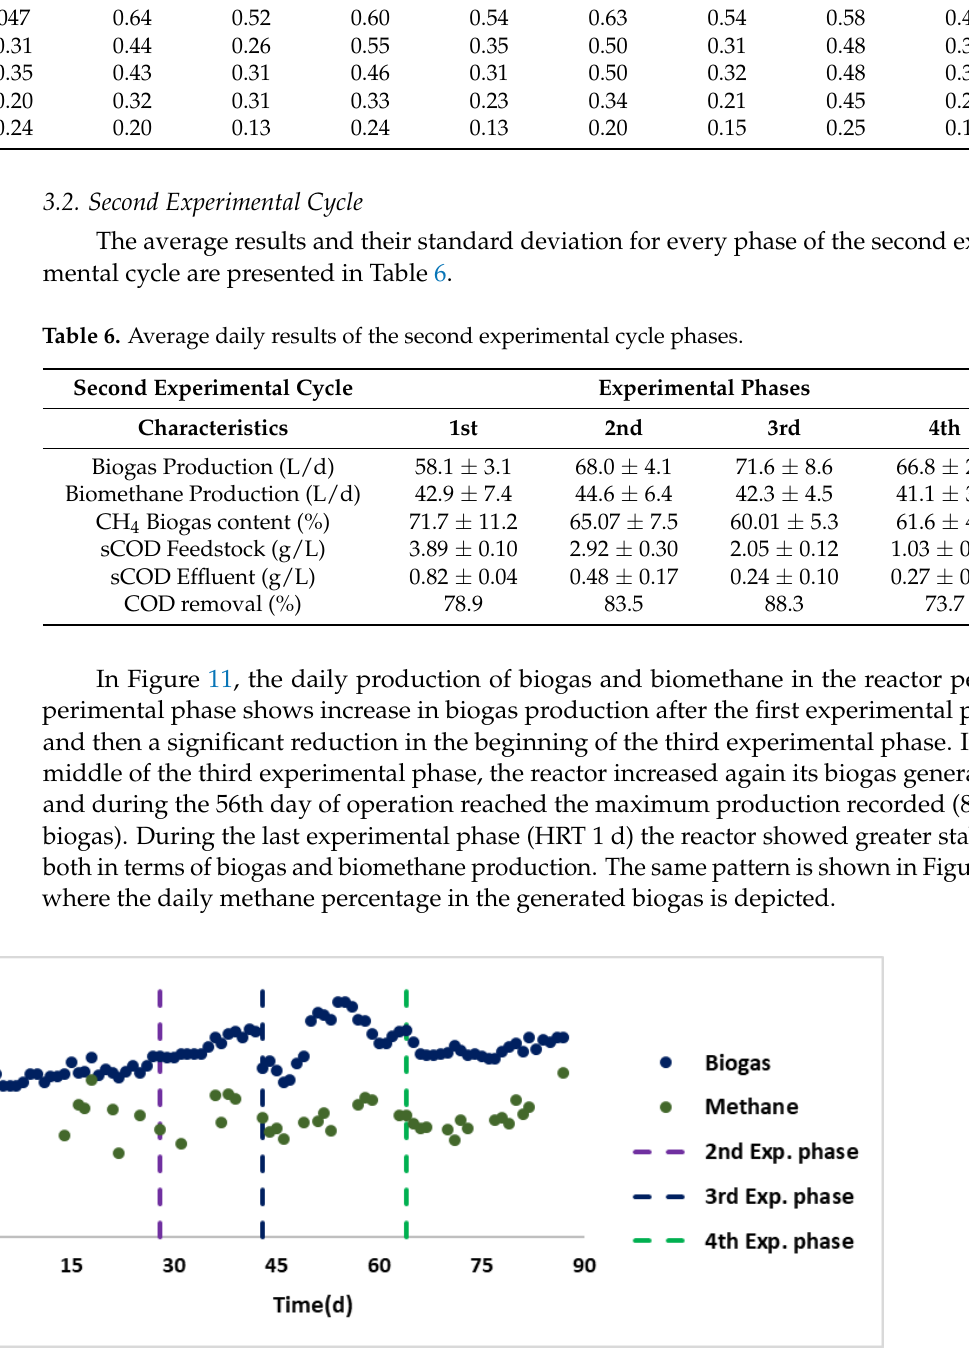
Figure 11 . Daily biogas and biomethane production. Figure 11. Daily biogas and biomethane